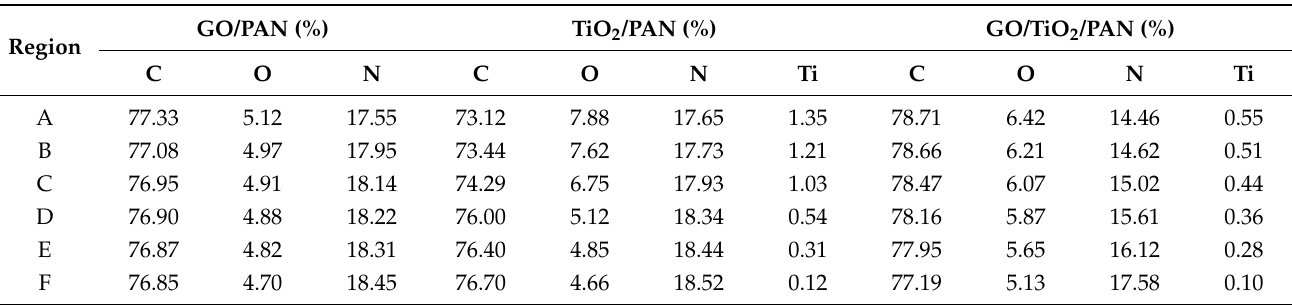
Figure 6. FESEM images of the top surfaces of ( a ), ( a` ), ( b ) and ( b` ) GO/PAN membranes and ( e ), ( e` ) and ( e`` ) GO/TiO 2 /PAN membranes, and the cross-sections of ( c ), ( c` ), ( d ) and ( d` ) GO/PAN membranes and ( f ), ( f` ), ( g ) and ( g` ) GO/TiO 2 /PAN membranes. Table 3. Relative content of C, O, N, and Ti in different regions of the GO/PAN, TiO 2 /PAN, and GO/TiO 2 /PAN